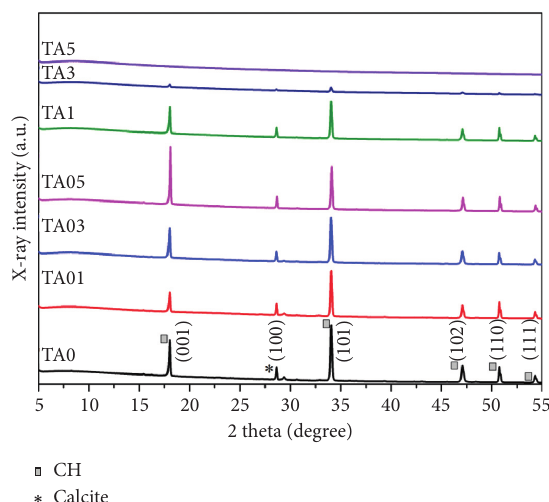
Figure 1: XRD patterns of CH precipitates with different dosages of TA.